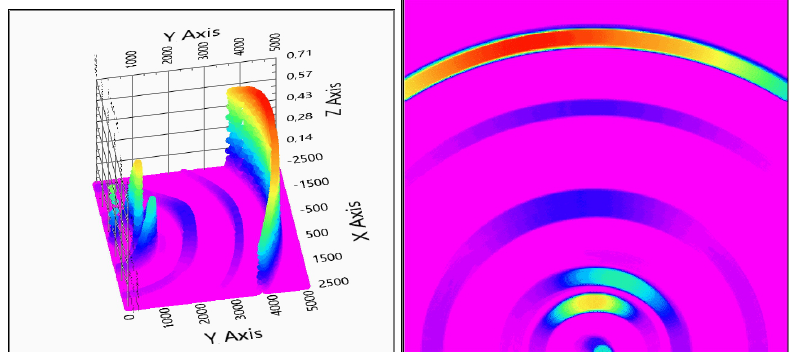
Figure 18. Evaluation of indoor test No. 2 (3 receivers). In the right column, the top view is also shown ( x , y : x , y space axis, z -axis: probability of solid object in x , y defined position).